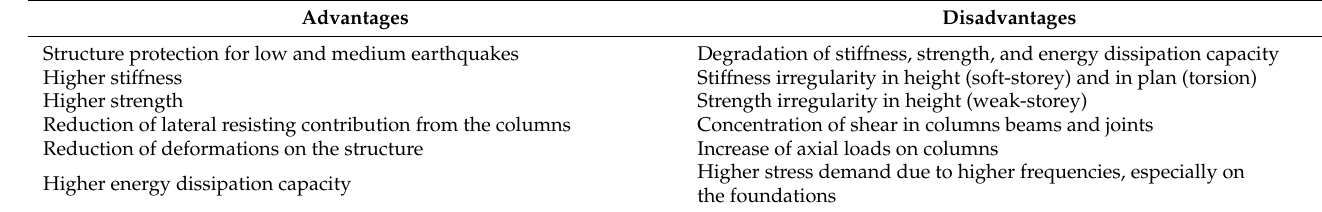
Table 1. Pros and cons of infill masonry walls on